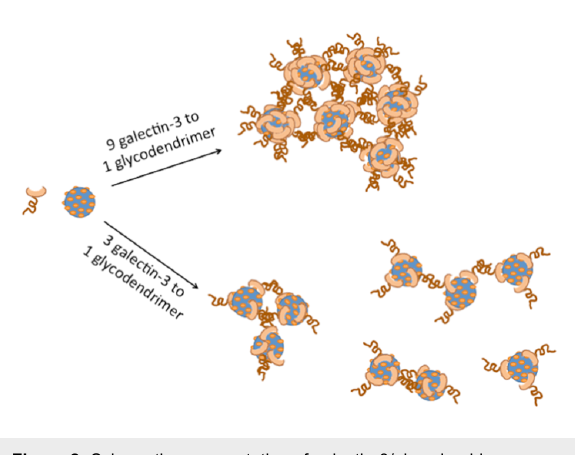
Figure 2: Schematic representation of galectin-3/glycodendrimer aggregates at varying